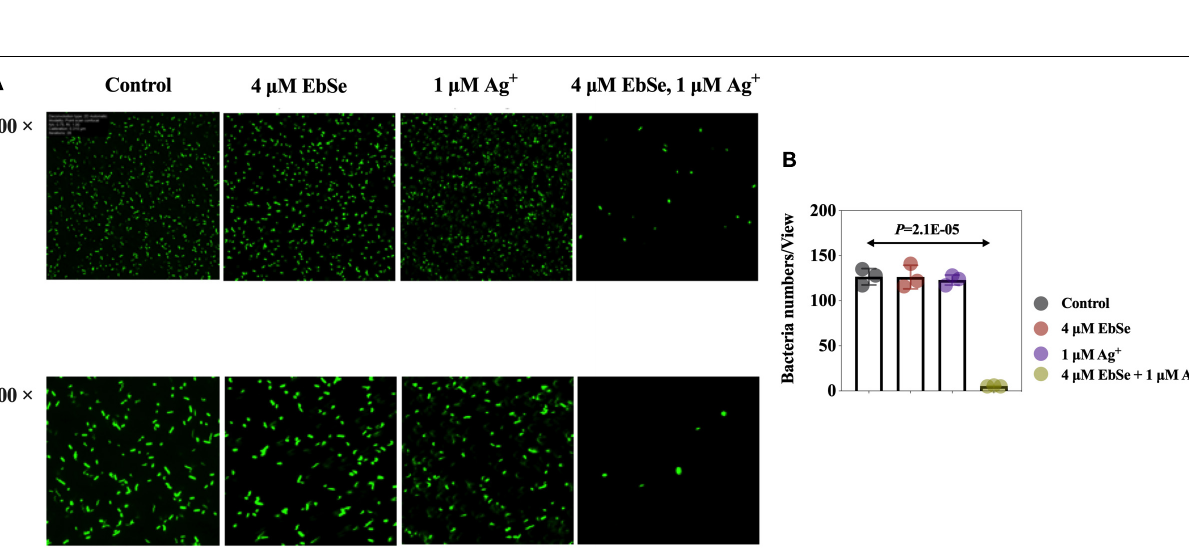
Frontiers in Microbiology |